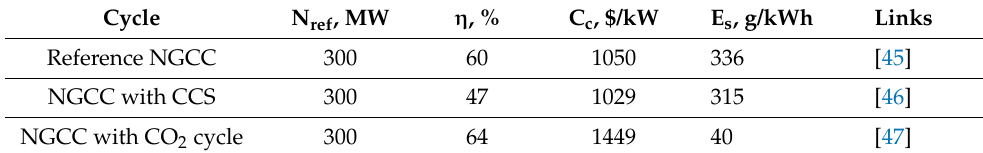
Table 3. Reference data for modern high-capacity thermal power plants.